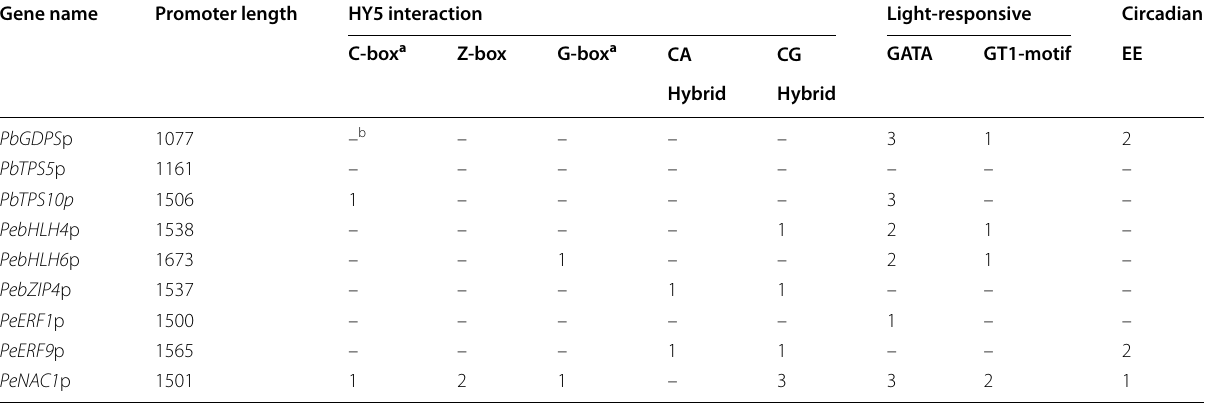
a The number of palindromic sequences was counted by the sense strand b The dash indicates that the cis -element is not detected